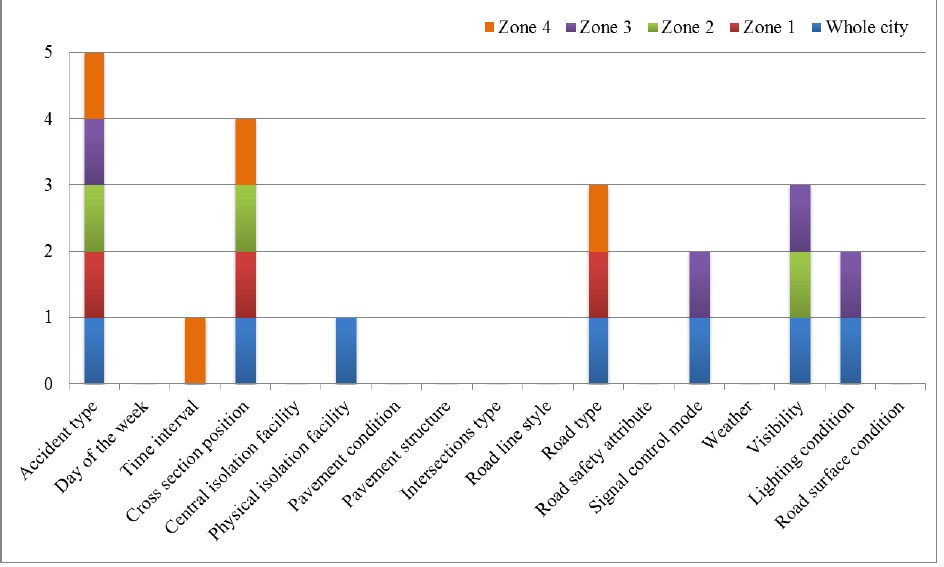
Figure 2. The statistical results of BLR.